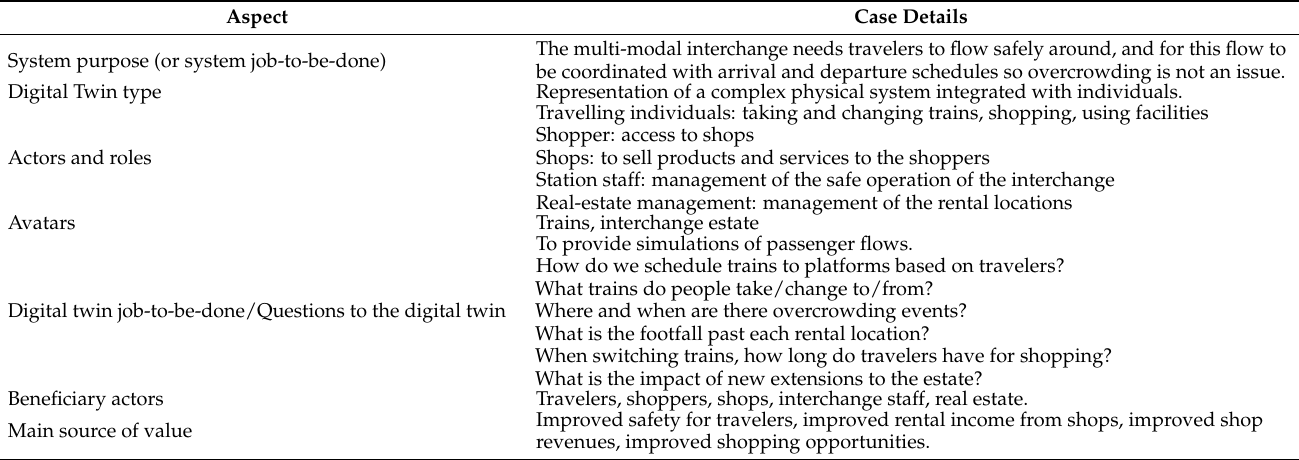
Table A11. Case 9—footfall around interchanges.